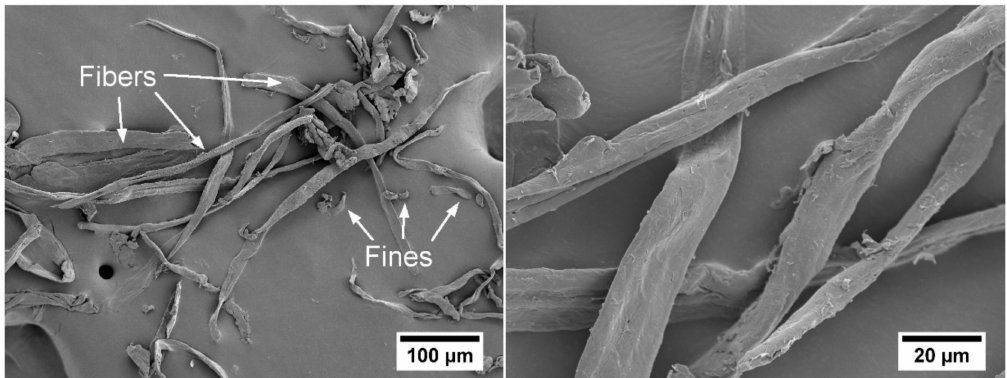
Figure 2. SEM images of HT / Soda fibers. Left) Fibers and fines are exemplified (magnification 200 × ). Right) Fibers observed at 1000 ×